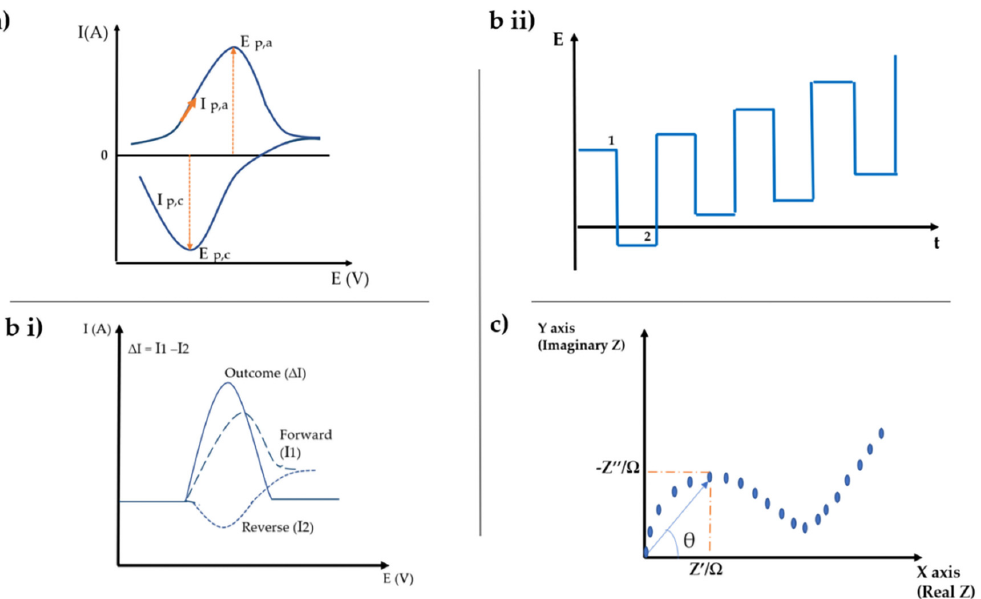
Figure 7. ( a ) —Typical voltammogram for a reversible system, where Ipa is the Anodic peak current and Ipc is the Cathodic peak current [74]. ( bi )— Scheme of application of potentials: sum of a staircase and a square wave [74]. ( bii )—Schematic square wave voltammogram of a redox reversible process [74]. ( c )—Nyquist plot that illustrates both real (Z ′ ) and imaginary (Z ″ ) components of impedance [68].